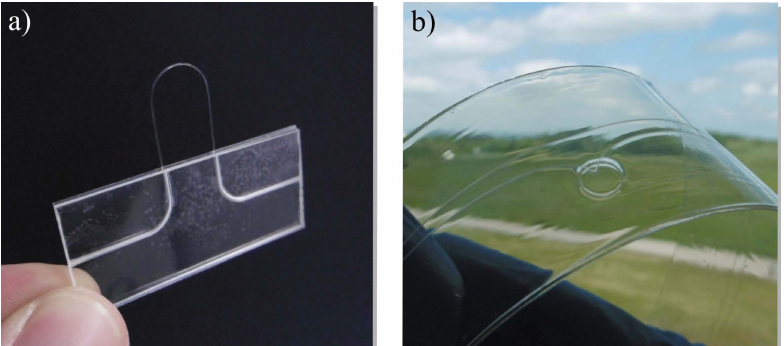
Figure 7. ( a ) Photograph of a U-bend humidity sensor utilizing a 250 µ m core plastic optical fiber (POF) with stripped cladding in the sensing region and ( b ) a laminated device with 100 µ m cyclic olefin polymer bare fiber laminated between two PMMA substrate